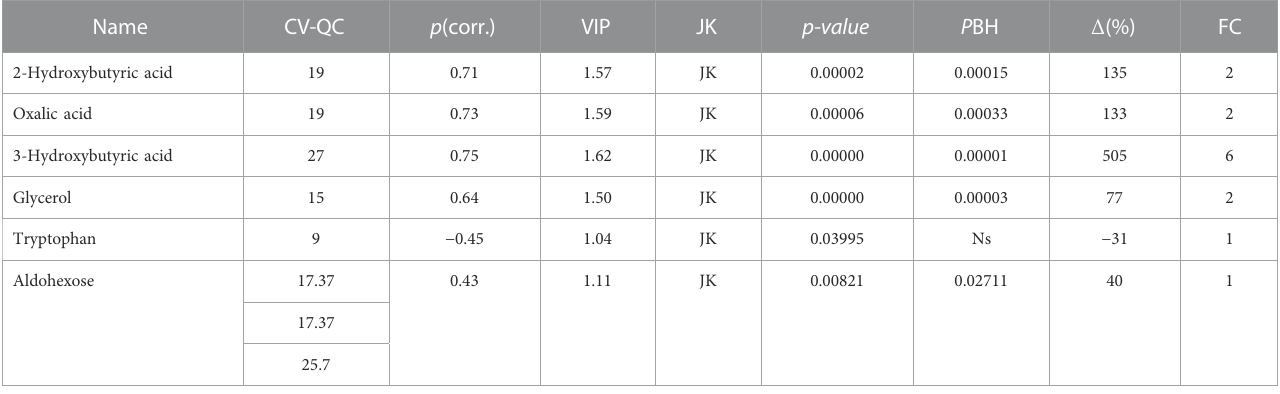
TABLE 2 Metabolites in the plasma signi fi cantly changed in gestational diabetic women compared to normoglycemic women. Name CV-QC p (corr.)